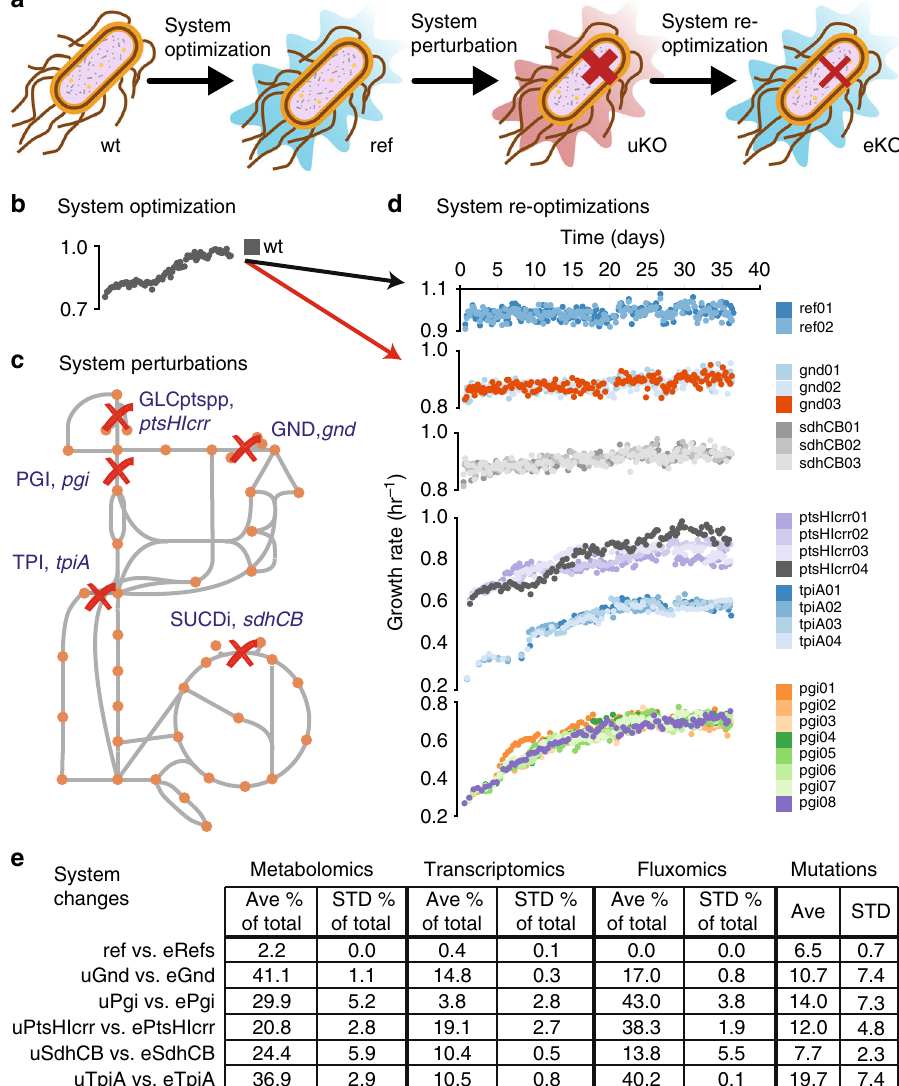
Fig. 1 Evolution of knockout (KO) strains from a pre-evolved (i.e., optimized) wild-type strain. a Experimental design using adaptive laboratory evolution (ALE) and enzyme knockouts to investigate system re-optimization following major metabolic perturbations. b An isolated wild-type (wt) E. coli (MG1655 K-12) previously evolved on glucose minimal media at 37 °C 31 was used as the starting strain for knockouts of key metabolic genes and subsequent re- evolution, or systems re-optimization. c Reactions disabled by the enzyme knockouts included the phosphotransferase sugar import system (ptsHIcrr), phosphoglucose isomerase (pgi), 6-phosphogluconate dehydrogenase (gnd), triophosphate isomerase (tpi), and succinate dehydrogenase complex (sdhCB). d Adaptive laboratory evolution trajectories of the initial reference knockout and evolved knockout lineages. e Counts of signi fi cantly different system components found for each evolved knockout relative to the unevolved knockout. Counts of metabolomic, transcriptomic, and fl uxomic data are given as the average and standard deviation of the percent of signi fi cant features compared to all features measured for the lineage; counts for mutations are given as the average and standard deviation of the number of signi fi cant features (see Methods for criteria for signi fi